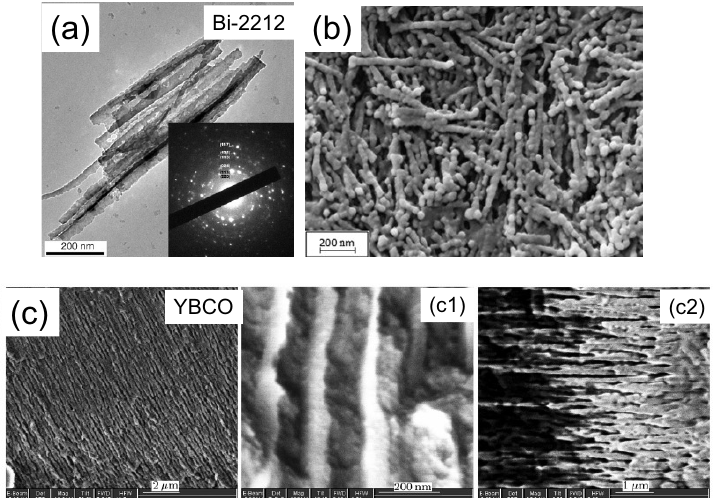
Figure 4. SEM images of ( a ) Bi-2212 nanowires [75] (Reprinted with permission from Ref. [75]. Copyright 2005 Elsevier), ( b ) YBCO nanowires produced with sol-gel approach [70] (Reprinted with permission from Ref. [70]. Copyright 2015 Elsevier), and ( c ) AAO template (low magnification) with